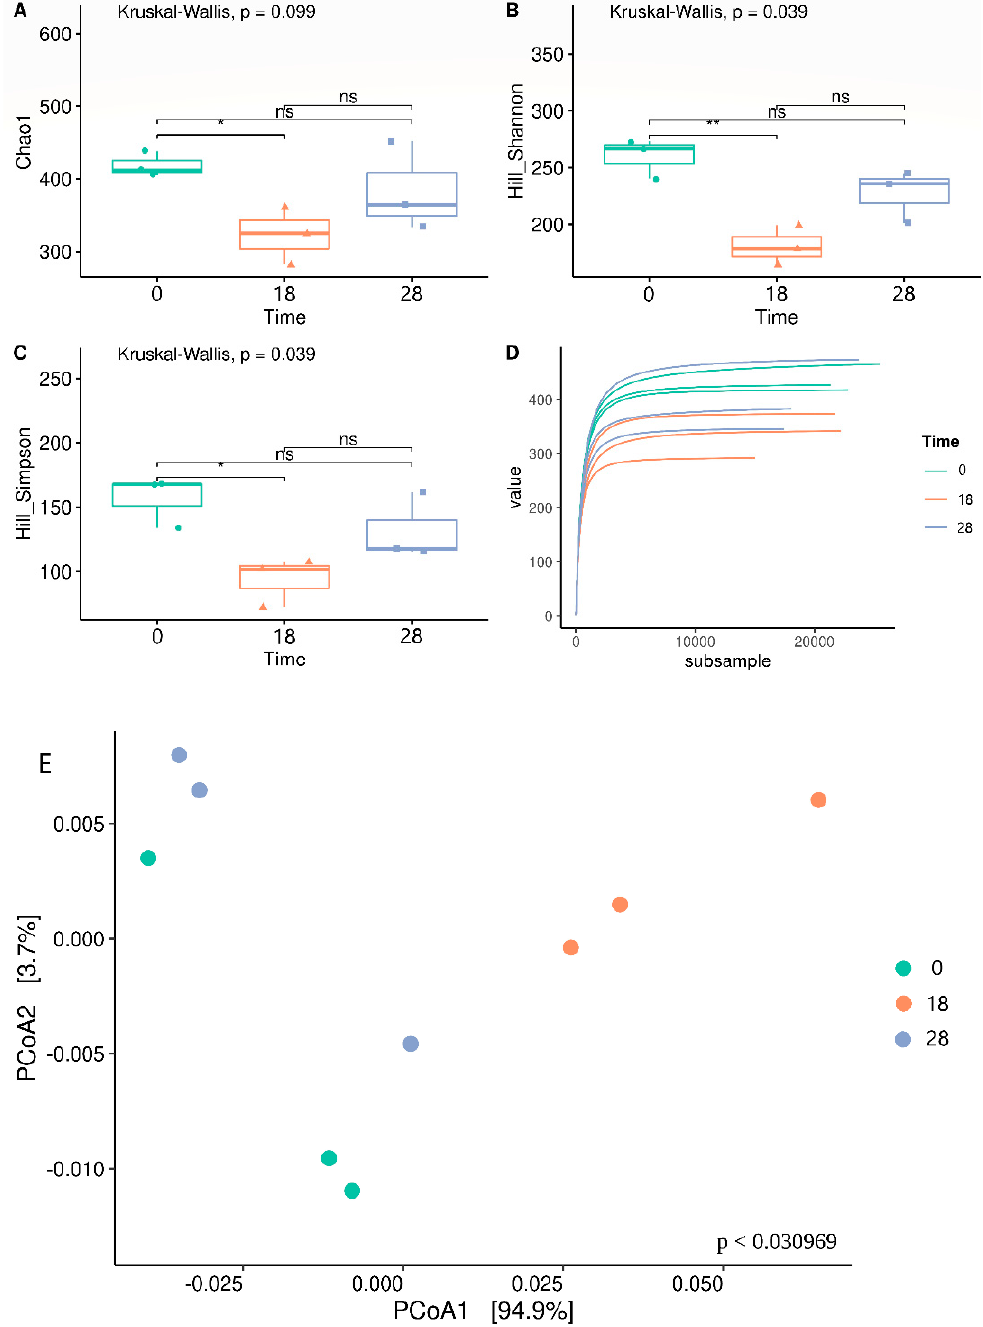
Figure 5. α diversity and β diversity of Lambertella sp. MUT 5852 incubation. Chao1 index ( A ) Hill–Shannon ( B ) Hill–Simpson index ( C ), each calculated after rarefaction to a coverage of 99.5%, and rarefaction curves of observed species of bacterial community composition ( D ). Box and whiskers represent the minimum (Q 0 ), 1st quartile (Q 1 ), median (Q 2 ), 3rd quartile(Q 3 ), and maximum (Q 4 ) of each group. Reported p -value is calculated by Kruskal–Wallis test ( α = 0.05). Post hoc statistical test is based on the Dunn test, with Benjamini–Hochberg correction for multiple comparisons: Notation for p -value: ns for p > 0.05. Principal component analysis (PCoA) ( E ) represents the bacterial community in presence of Lambertella sp. MUT 5852, based on weighted UniFrac distance for each sample replicate. Colours indicate time category for each datapoint. The percentage reported on axes represents the amount of total variance depicted by each. The p -value was calculated by the ADONIS function (Vegan R package v 2.5-7) between weighted UniFrac distances and sample groups, using the Bray–Curtis method with 1000 repetitions.